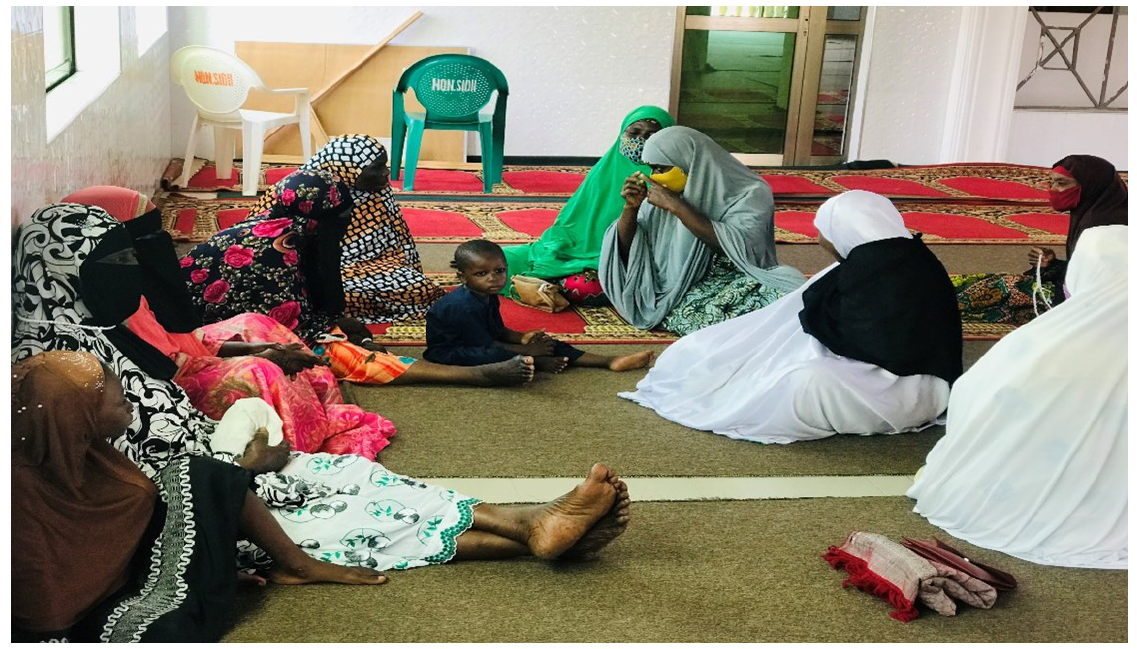
Figure 3 A focus group discussion with Muslim women at the Malam Yunus mosque in Madina Zongo , picture taken by the